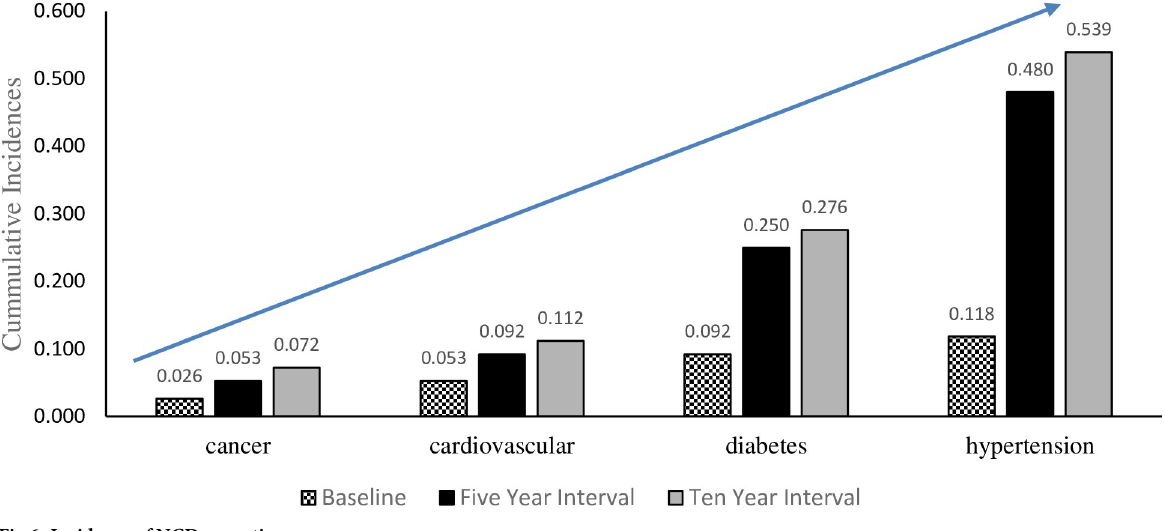
Fig 6. Incidence of NCDs over time.